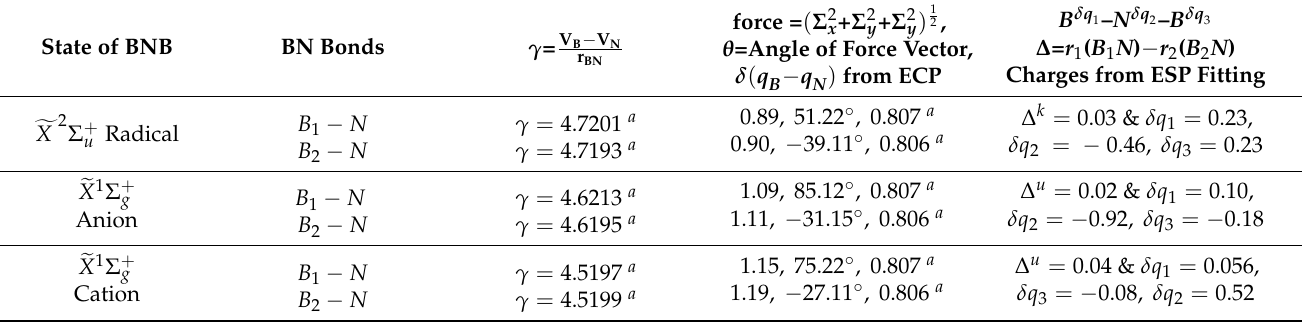
Table 3. Charges from ECP (effective core potential) fitting for BNB with several methods and basis sets.